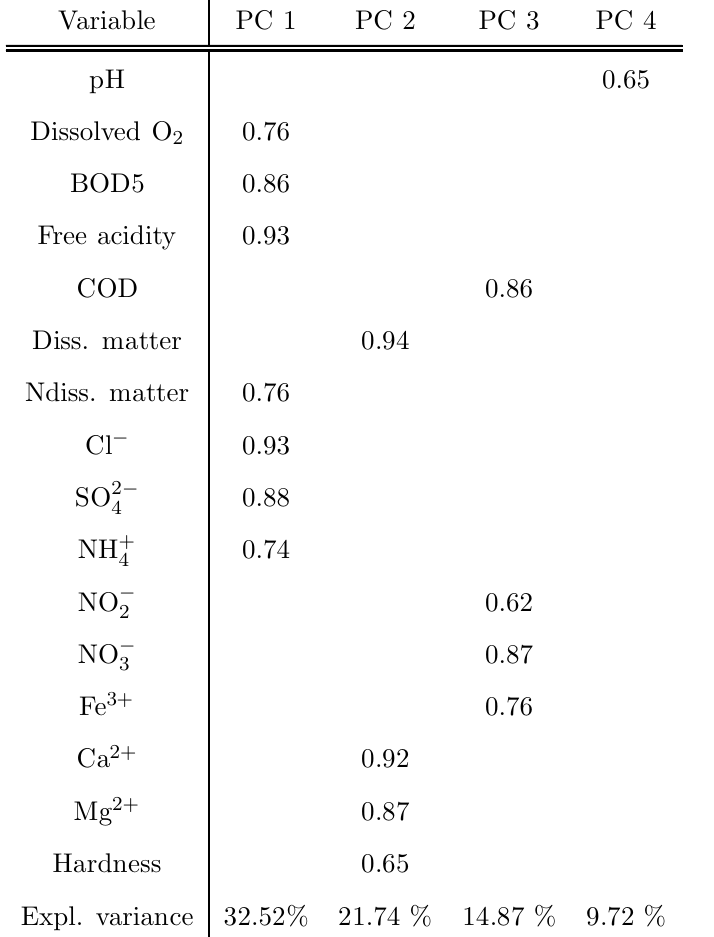
Table 3 Factor loadings (only statistically signi› cant › gures are